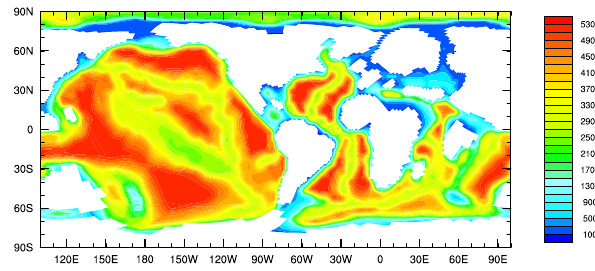
Figure 1. Paleocene topography (m Fig. 1. Paleocene topography (m depth).